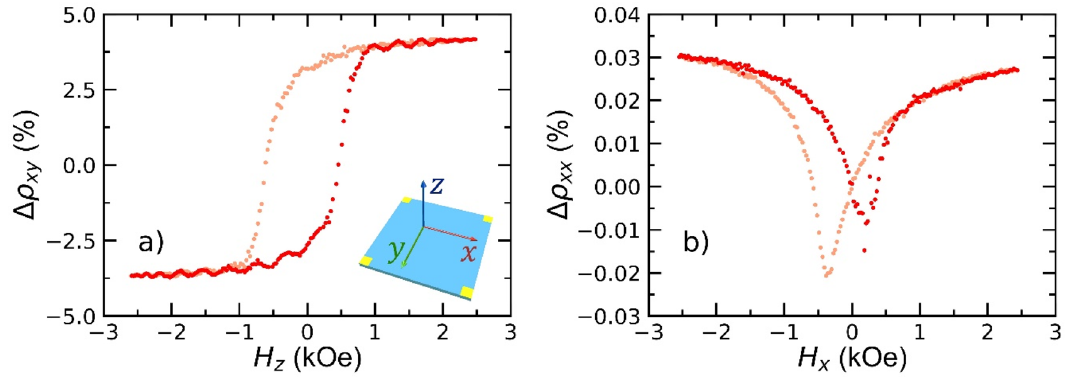
Figure 6. Magneto-transport characterisation of a Nb(15)/Pt(0.8)/Co(1)/Pt(0.6)/Cu(5)/MgO(3) multilayer. The sample is cooled down from room temperature in the absence of a magnetic field. Subsequent data is recorded at T = 4 K. Degaussing takes place before each measurement. During measurements the field is swept at a rate of 25 Oe/s. Forward and reverse field sweeps are indicated by red and pink markers respectively. ( a ) Hall resistivity percentage change, �ρ xy , as a function of out-of-plane applied field, H z . Note, �ρ xy = (cid:31) ρ xy ( H ) − ρ xy ,0 (cid:30) /ρ xy ,0 , where ρ xy ,0 = (cid:31) ρ forward ( H = 0 ) − ρ reverse ( H = 0 ) (cid:30) / 2 . Inset, schematic of the measurement orientation. Yellow squares at the corners indicate electrical contact points. ( b ) AMR resistivity percentage change, �ρ xx , as a